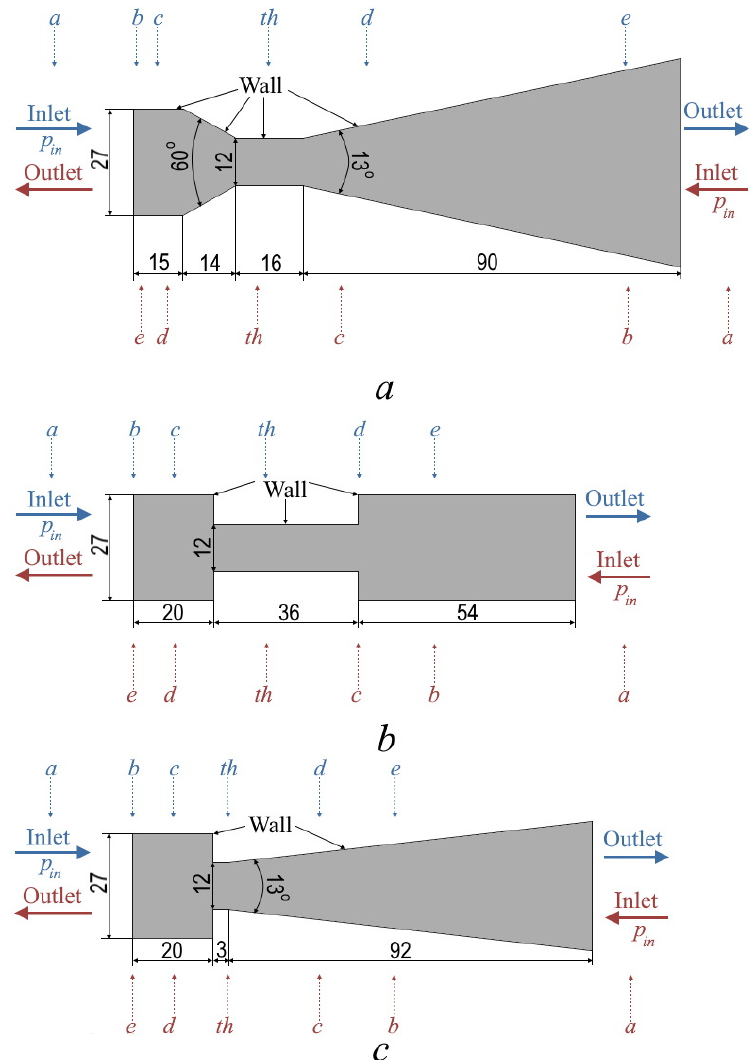
Figure 3. Computation domains. ( a ) venturi tube, ( b ) cylindrical nozzle, ( c ) diverging nozzle